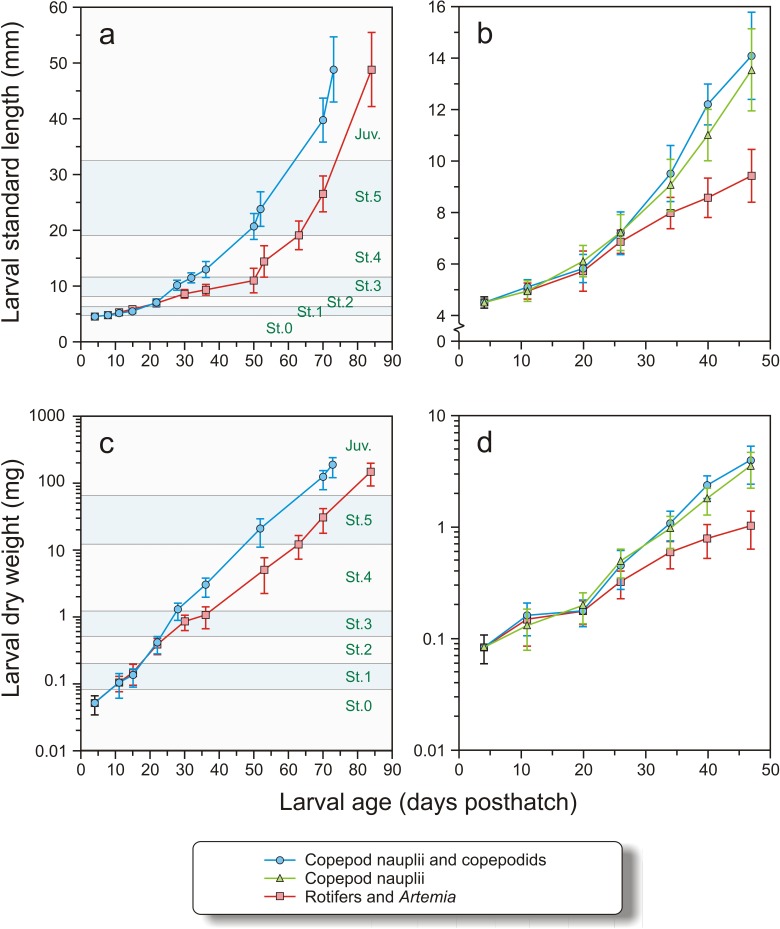
Growth in length and dry weight in both experiments.Growth in length (mm) and dry weight (mg) in Exp-1 (A and C) and Exp-2 (B and D) of cod larvae fed either rotifers and Artemia or copepods. In Exp-1, larvae were fed copepods of increasing size. Stages (St. 0–5 and Juveniles, see text for explanation) are indicated. In Exp-2, one group was fed copepod nauplii and another group copepods of increasing size. Note logarithmic scale in C and D.